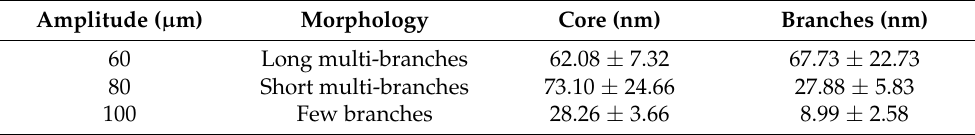
Table 8. The influence of amplitude sonication to morphology, average core and branches of GNS.